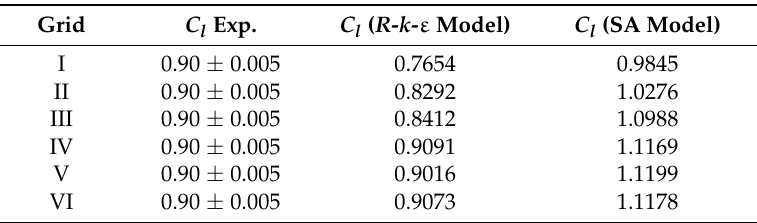
Table 4. Lift coefficient values for the NACA 0015 airfoil at α = 12 ◦ , δ = 0 ◦ and Re = 10 5 using RANS models. SA,